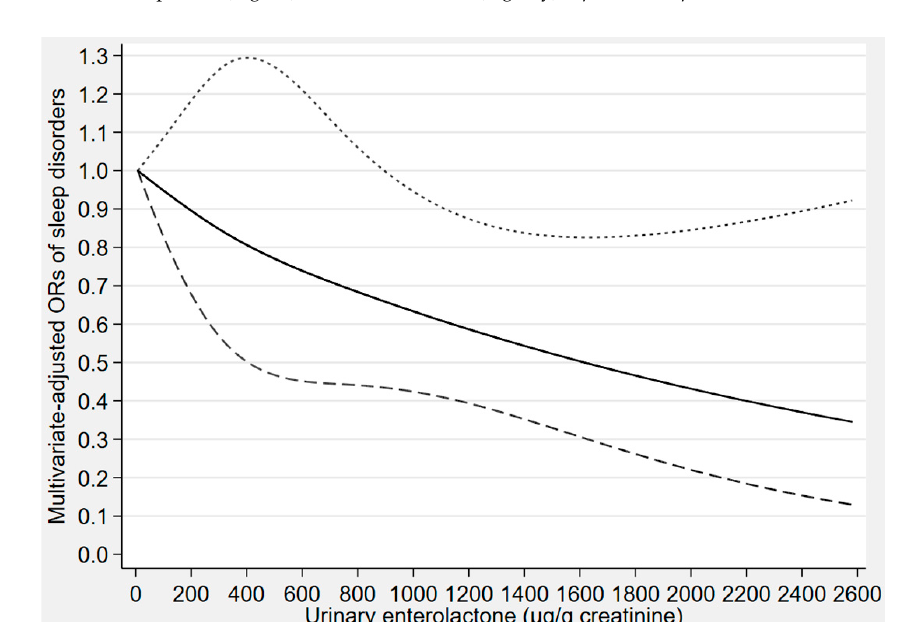
Figure 2. Concentration–response relationship of the urinary enterolactone concentration with sleep disorders. The solid line represents the estimated odds ratios (ORs) and the dashed lines represent their 95% confidence intervals. The relationship was adjusted for gender, age, marital status, race, occupation, family income, educational level, body mass index, smoking status, alcohol consumption, use of female hormones, physical activity, caffeine intake, C-reactive protein, hypertension, depressive symptoms, diabetes, and the other five phytoestrogens (tertiles).